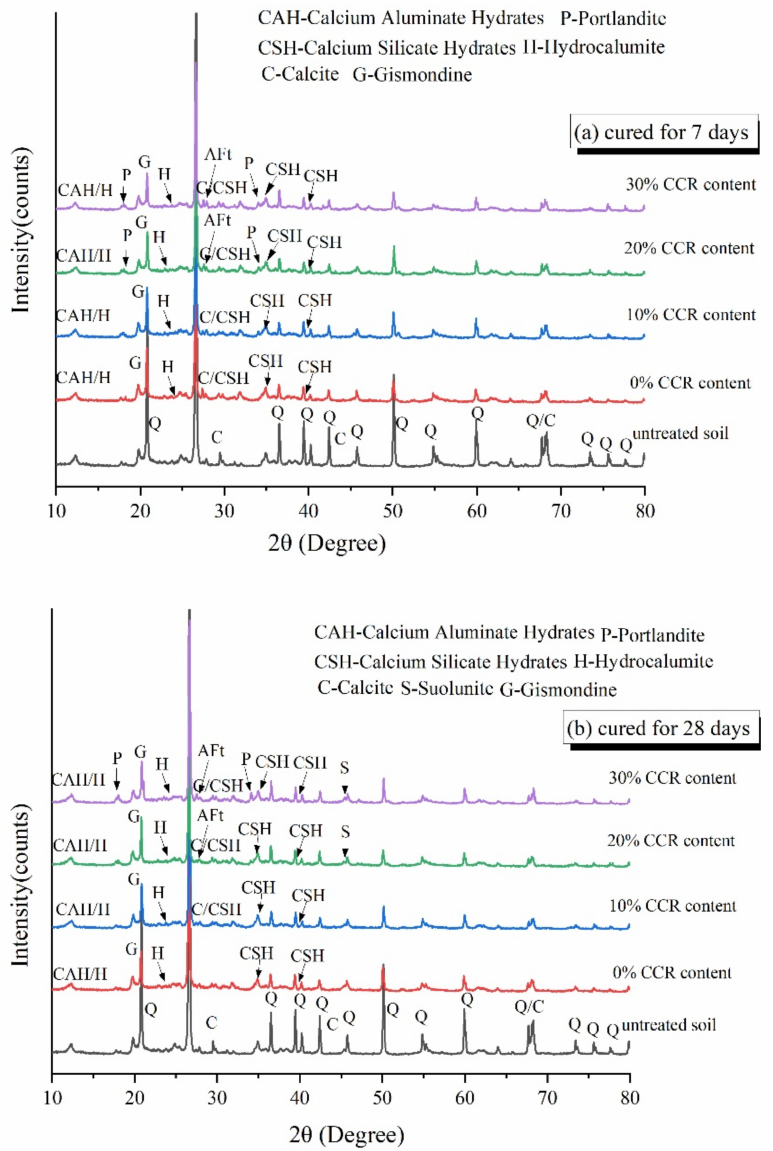
Figure 14. X-ray diffraction patterns of untreated and CCR stabilized soil cured for: ( a ) 7 days and ( b ) 28 days with 20% cement